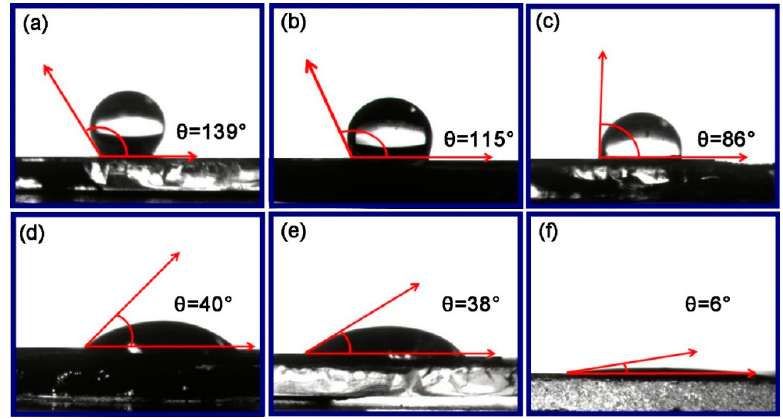
Figure 4. Water contact angle of Ru-Zn(x)/m-ZrO 2 after catalytic experiments: ( a ) Ru/m-ZrO 2 AH; ( b ) Ru-Zn(0.06)/m-ZrO 2 AH; ( c ) Ru-Zn(0.33)/m-ZrO 2 AH; ( d ) Ru-Zn(0.60)/m-ZrO 2 AH; ( e ) Ru-Zn (0.86)/m-ZrO 2 AH; ( f ) Ru-Zn (1.02)/m-ZrO 2 AH.